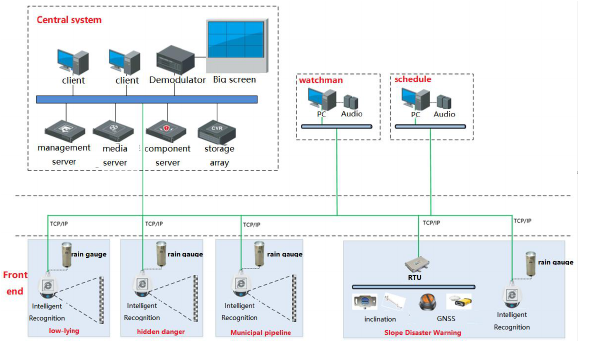
Figure 3 . System business architecture diagram.